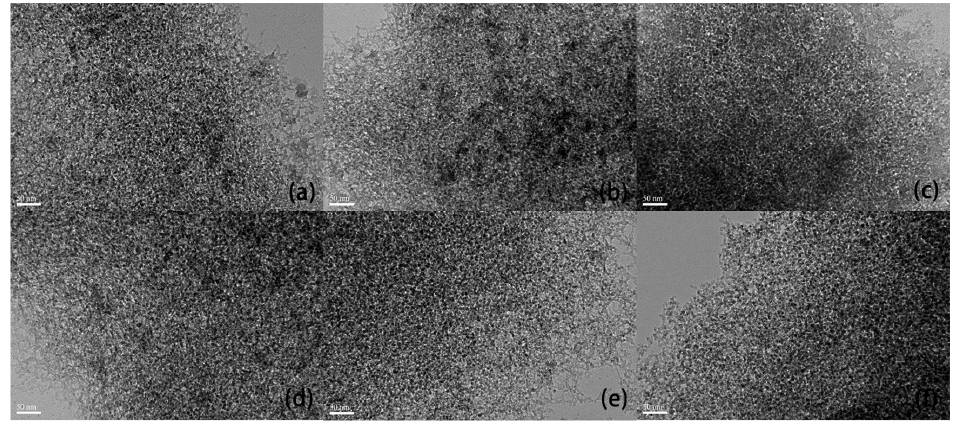
Figure 5. The TEM images of the: ( a ) SiO 2 aerogel and composition-gradient Fe 2 O 3 /SiO 2 composite. Aerogel at different positions: ( b ) A; ( c ) B; ( d ) C; ( e ) D; ( f ) E.